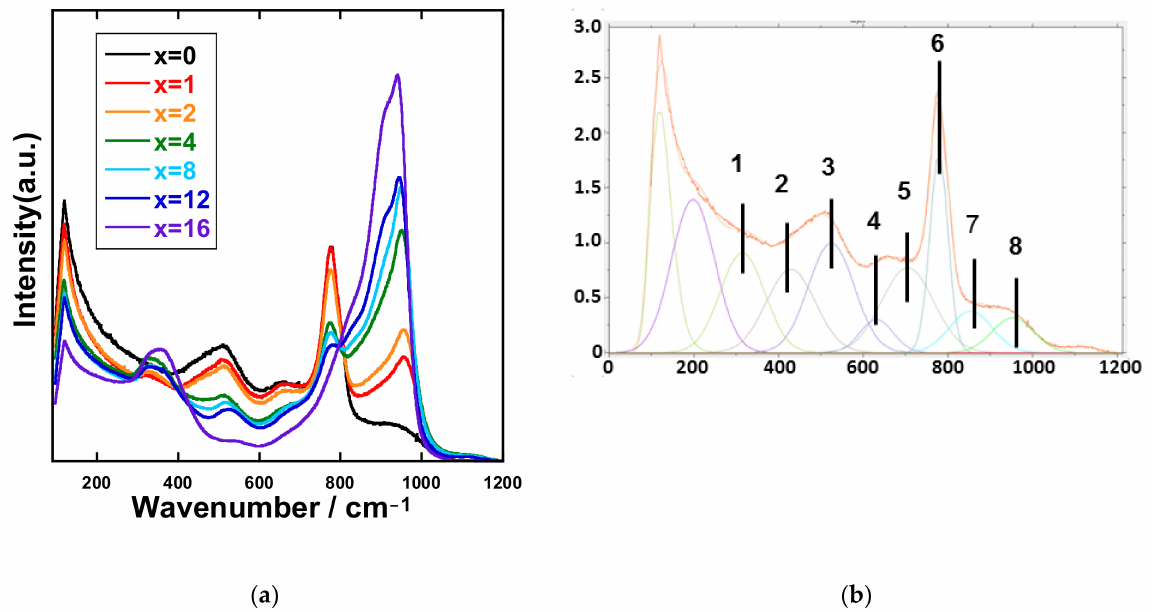
Figure 6. ( a ) Area normalized Raman spectra of 0–16 mol% Ca 3 WO 6 glass samples and ( b ) deconvoluted Raman spectra of 33CaO–67B 2 O 3 glass.